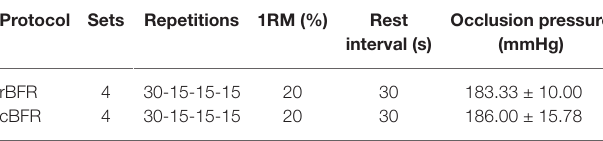
TABLE 1 | Overview of training variables. Protocol Sets Repetitions 1RM